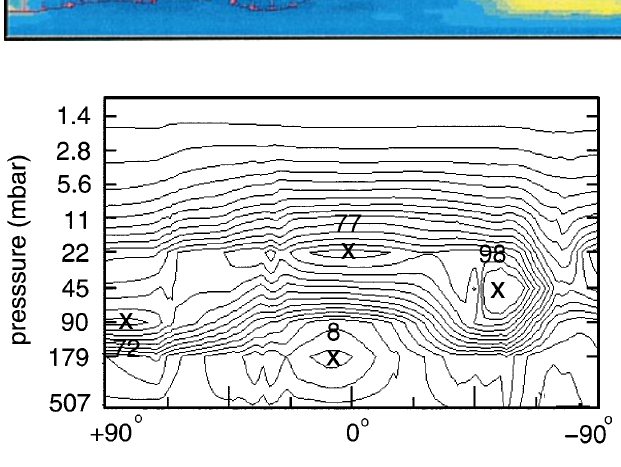
Fig. 8. a SBUV ozone field in Dobson Units obtained using ordinary kriging with the spherical model C 0 (cid:136) 0, C 1 (cid:136) 460 and R (cid:136) 50), at 89.6 mbar (layer 3), October 5, 1988. Interval is 5 DU. b Same as a but with spherical model C 0 (cid:136) 0, C 1 (cid:136) 100 and R (cid:136) 50, at 11.2 mbar (layer 6), October 5, 1988. Interval is 2.5 DU